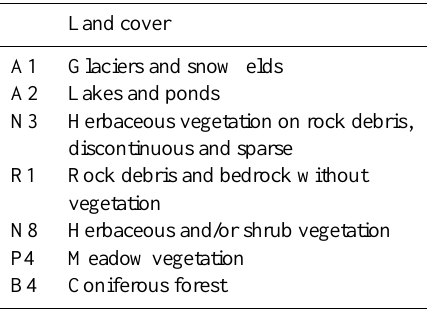
Fig. 2. Stream annual hydrograph (Masino stream) as hydrometric height (cm). The dots refer to sampling